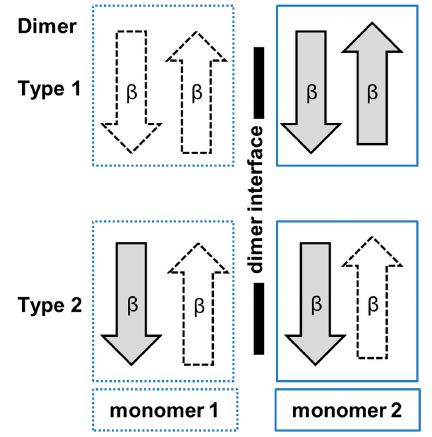
Figure 21. Schematic figure illustrating the topology of the β -strands found in the two most common types of dimer interface in GNAT proteins. Strands from one monomer are colored white, and those from the second monomer are colored gray.